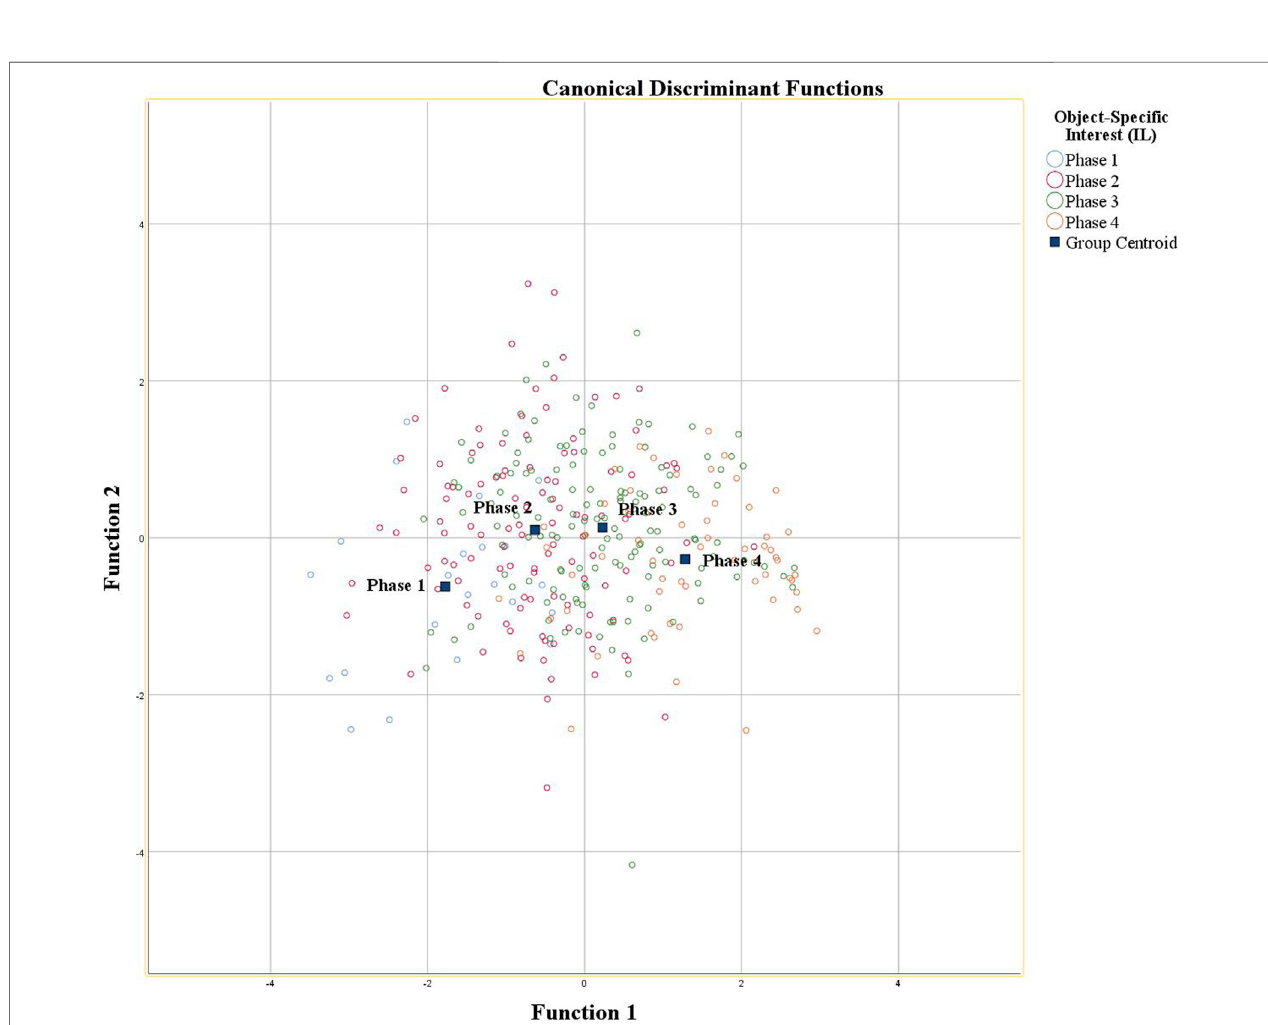
FIGURE 3 | Canonical discriminant functions 1 and 2 for interest in IL, phases